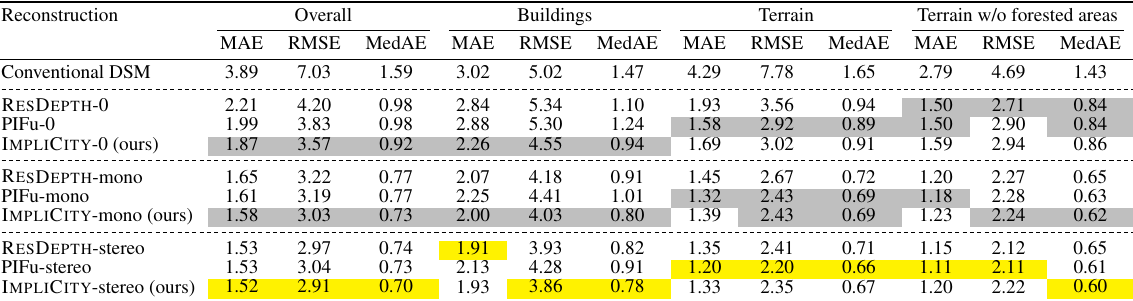
Table 1. Quantitative comparison of I MPLI C ITY with conventional DSM generation, and with learned DSM refinement based on either explicit (R ES D EPTH ) or implicit (PIFu) 2D representations (cf. Section 4.3). Methods are grouped according to their inputs: -0: point cloud/DSM, -mono : point cloud/DSM and one ortho-image, -stereo : point cloud/DSM and two ortho-images. All values are meters. Gray numbers are best for a given input, yellow numbers are best